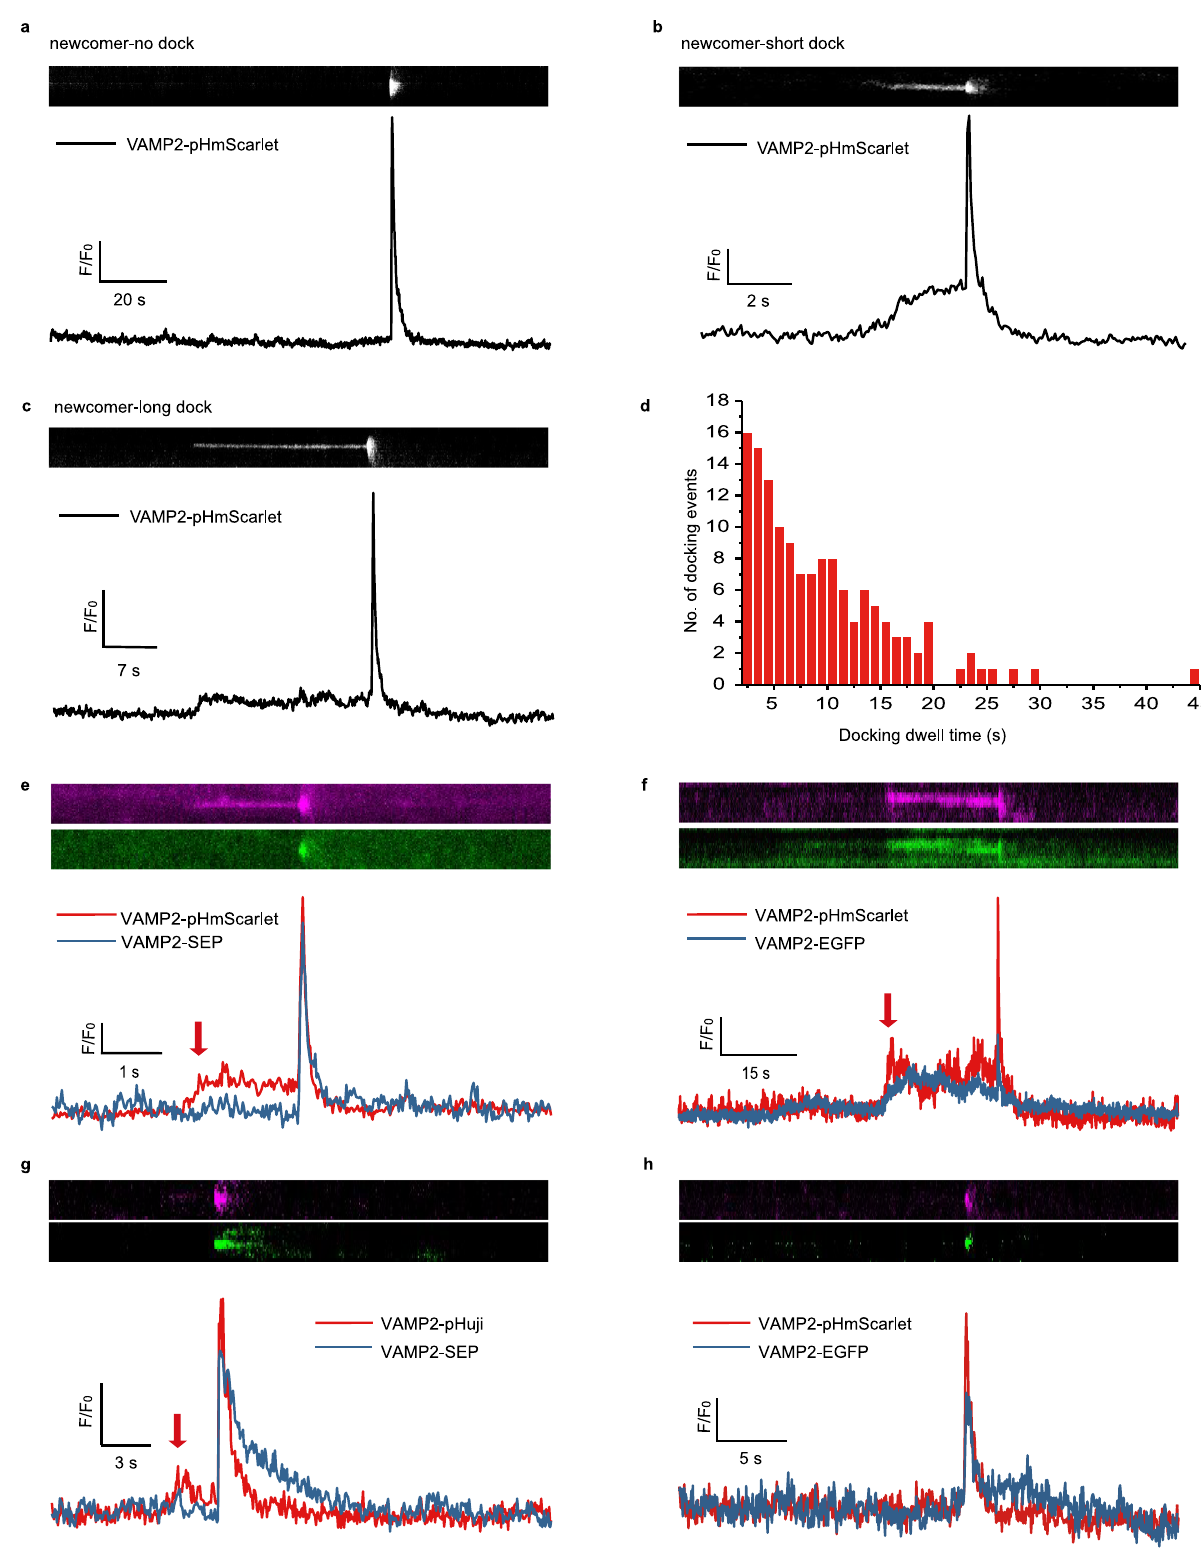
Fig. 5 Detection of the docking stage in INS-1 cells. Representative kymograph and the corresponding time-lapse fl uorescence-intensity curves showing the distinct kinetic properties of a docking-free, b short docking, and c long docking exocytotic events. d Distribution of docking dwell times (total exocytotic evens, n = 138; three cells were examined over two independent experiments). Representative kymograph and corresponding time-lapse fl uorescence-intensity curves showing the exocytosis of the same vesicle co-labeled with e VAMP2-pHmScarlet (magenta) and VAMP2-SEP (green), f VAMP2-pHmScarlet (magenta) and VAMP2-EGFP (green), g VAMP2-pHuji (magenta) and VAMP2-SEP (green), or h VAMP2-pHmScarlet (magenta) and VAMP2-EGFP (green). Source data is provided as a source data fi